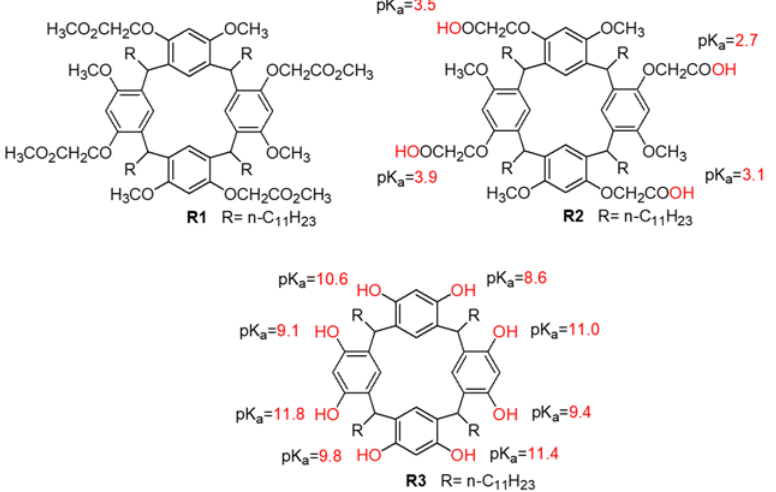
Figure 3. Structure of amphiphilic resorc[4]arenes R1 , R2, and R3 , and pK a of acid groups calculated by Marvin program.